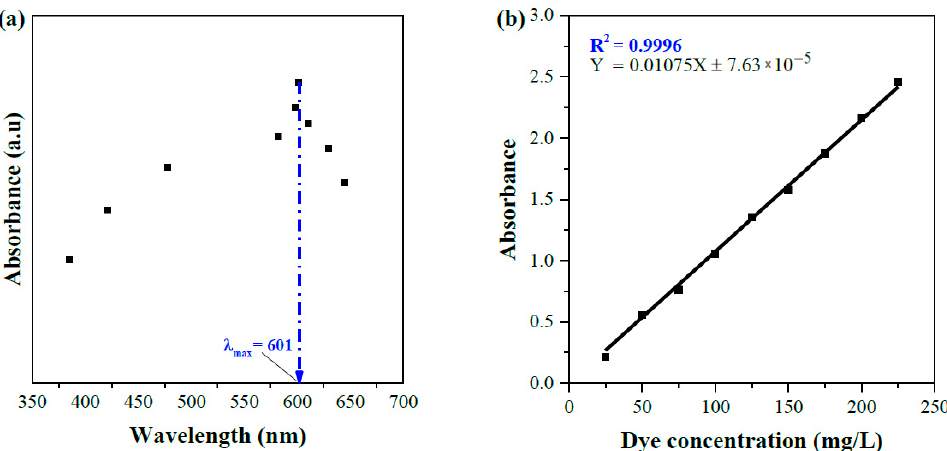
Figure 2. ( a ) Determination of wavelength for maximum absorption; ( b ) calibration curve of standard dye solution at λ max = 601 nm, pH ~ 7, and T = 25 ◦